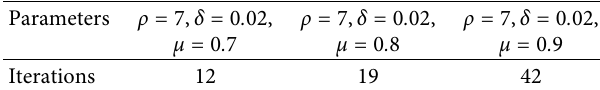
Table 3: Algorithm 2 (numerical results). Parameters